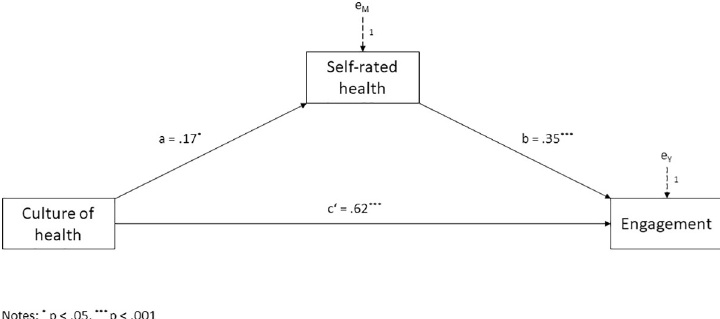
Fig 2. Mediation model. Self-rated health mediating the effect of workplace culture of health on employee engagement.